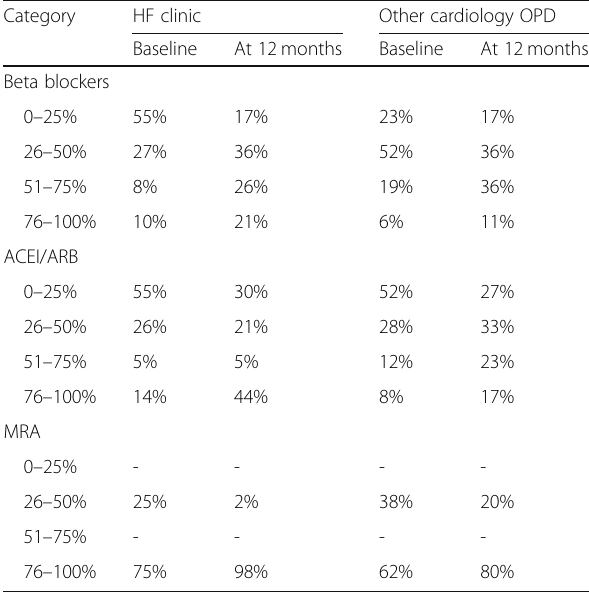
Table 3 Percentage of target doses achieved by the drugs